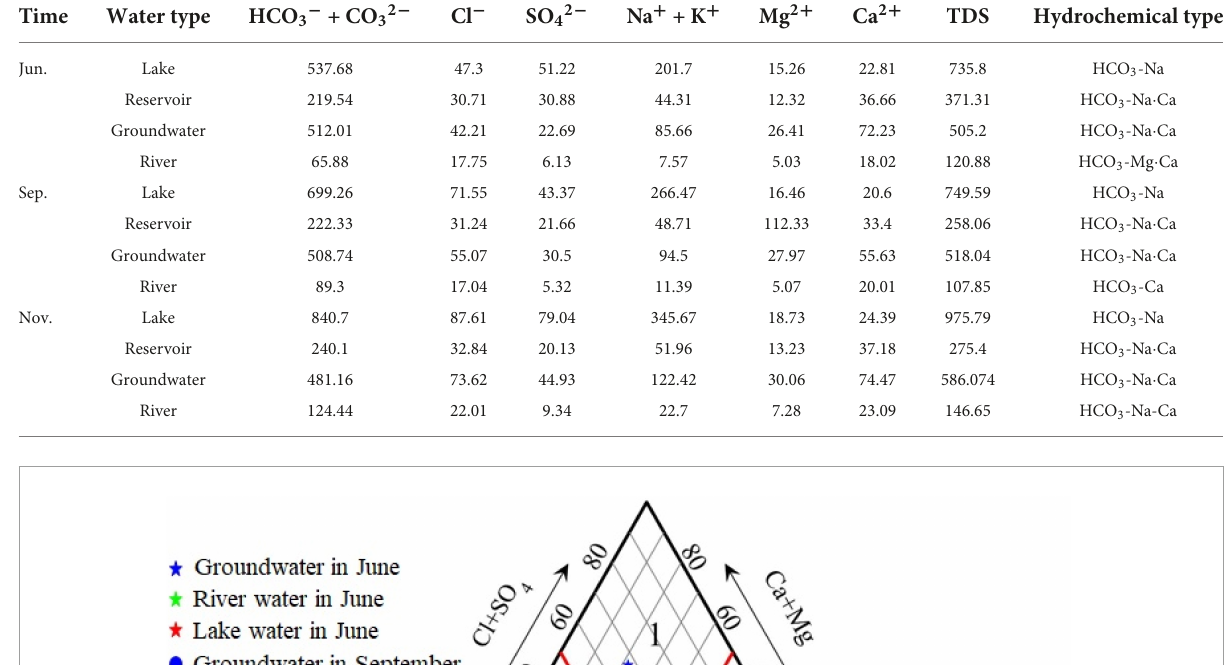
TABLE 1 Average concentration of chemical components in water (mg/L).